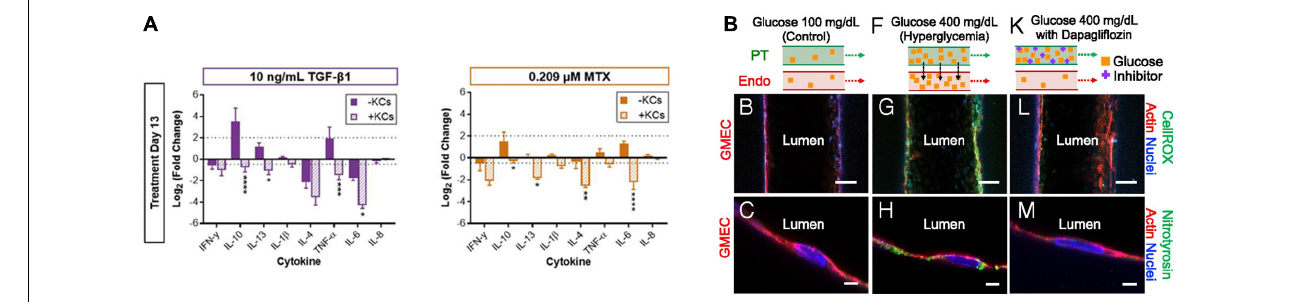
FIGURE 5 | (A) Impact of Kupffer cells on the chemically induced inflammatory response of 3D bioprinted liver tissue models (* p < 0.05; ** p < 0.01; *** p < 0.001; **** p < 0.0001). Reprinted with permission from Norona et al. (2019). (B) Pathophysiological features of GMEC lumen under normo- and hyperglycemic conditions indicated by immunofluorescen staining. Reprinted with permission from Lin et al. (2019).